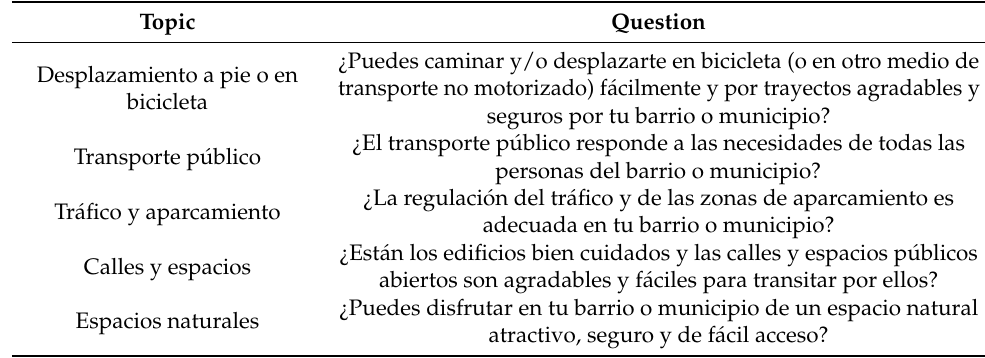
Table A1. Themes and main questions of Entornos de Vida Tool (in